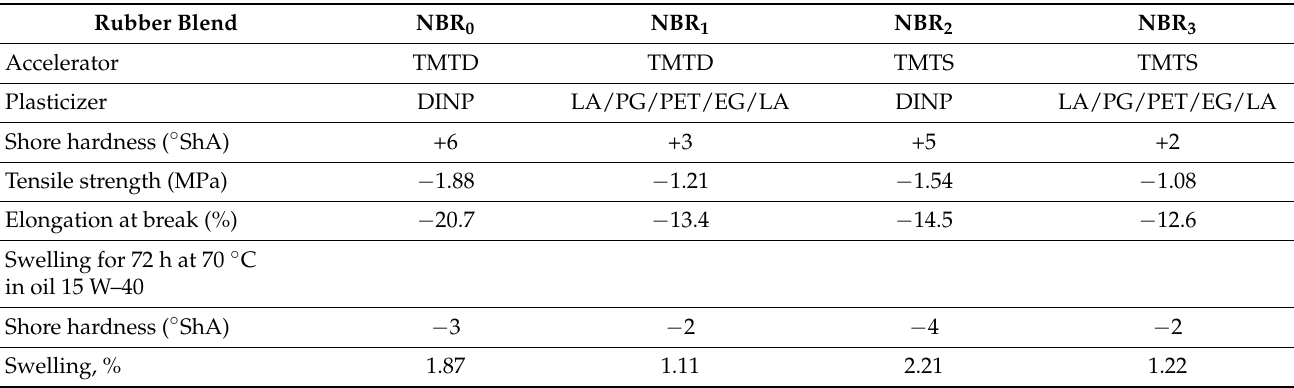
Table 12. The change of NBR-based product properties after aging in the air at 100 ◦ C for 70